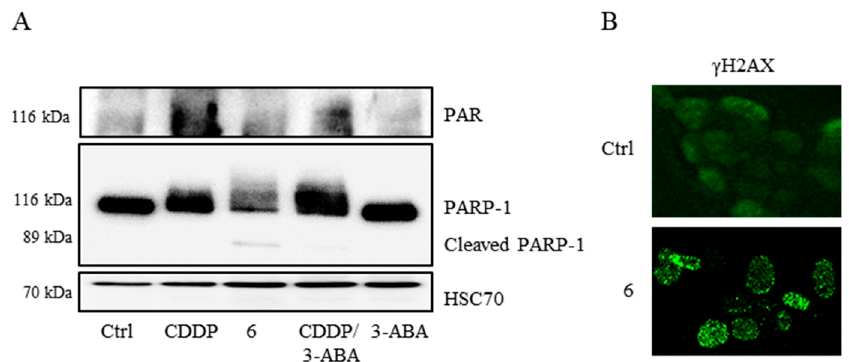
Figure 4. ( A ) Representative Western blot showing poly(ADP-ribose) (PAR) and PARP-1